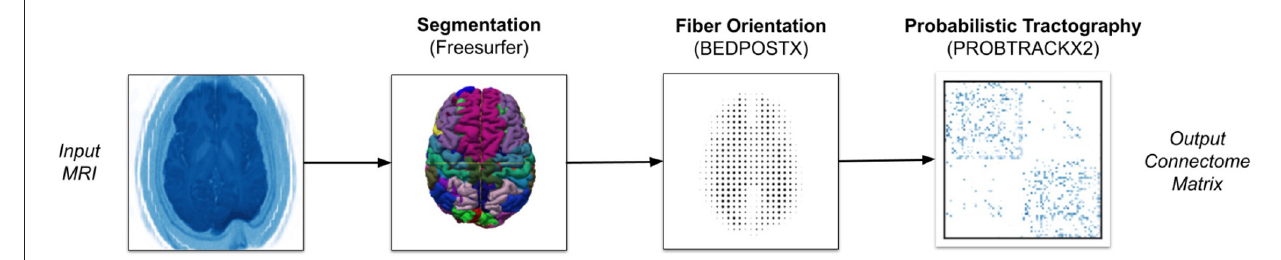
FIGURE 1 | Overview of MaPPeRTrac pipeline.